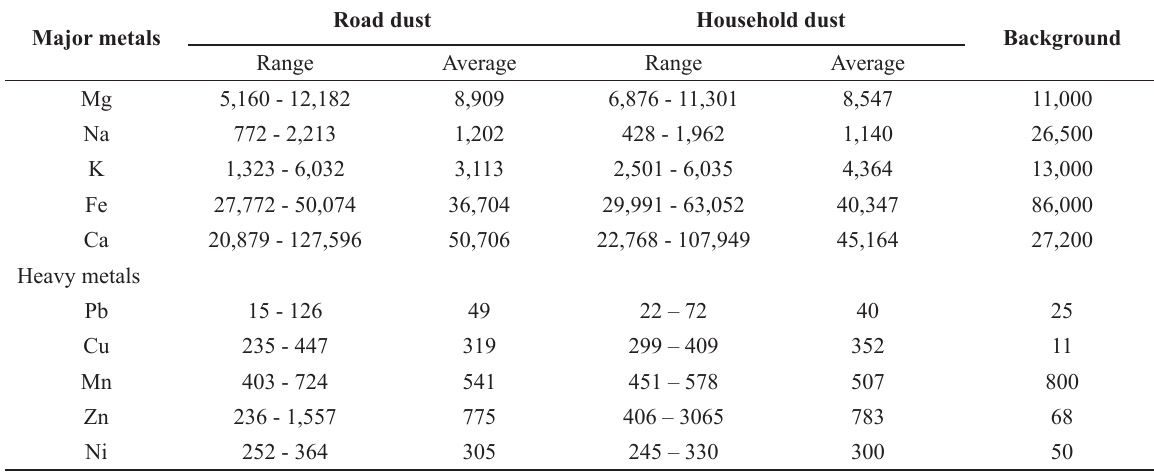
Table 4: Concentrations of major and heavy metals (mg/kg) of samples studied.